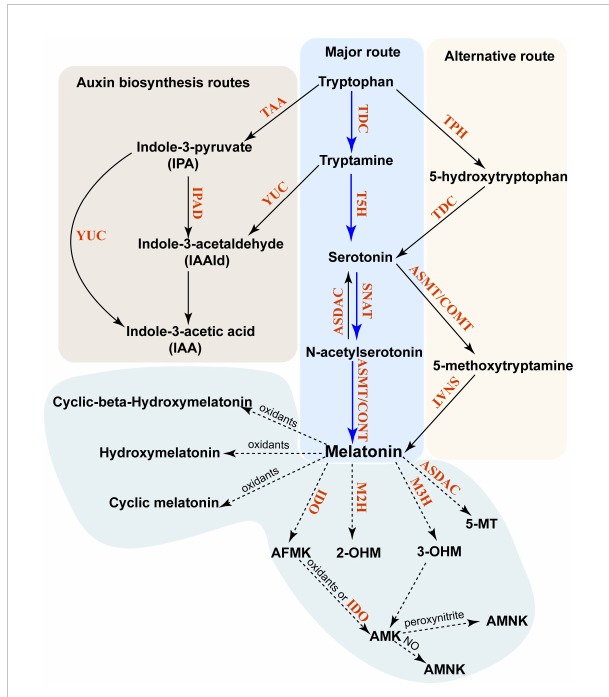
FIGURE 1 Biosynthesis and metabolism of phytomelatonin in plants. The major pathway of phytomelatonin synthesis is indicated by solid blue arrows , whereas the alternative pathway is indicated by solid black arrows . The phytomelatonin metabolism pathway is marked by dashed arrows . All enzymes in these pathways are indicated in red . TDC , tryptophan decarboxylase; TPH , tryptophan-5-hydroxylase; T5H , tryptamine-5-hydroxylase; SNAT , serotonin N - acetyltransferase; AANAT , aralkylamine- N -acetyltransferase; ASMT , N -acetylserotonin methyltransferase; COMT , caffeic acid O - methyltransferase; ASDAC , N -acetylserotonin deacetylase; AADC , aromatic- L -amino acid decarboxylase; M2H , melatonin 2- hydroxylase; M3H , melatonin 3-hydroxylase; AMK , N -acetyl-5- methoxykynuramine; AFMK , N 1 -acetyl- N 2 -formyl-5- methoxyaminourea; IDO , indoleamine 2,3-dioxygenase; 2-OHM , 2- hydroxymelatonin; 3-OHM , cyclic